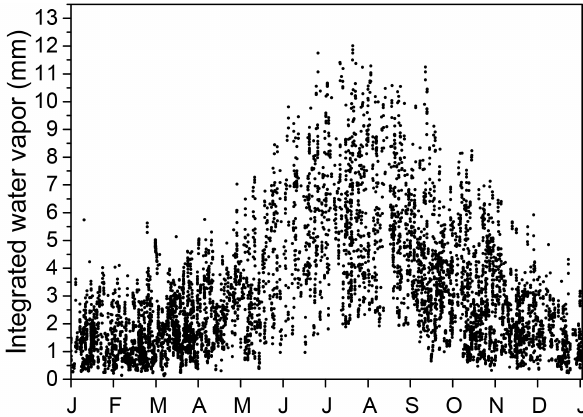
Figure 3. Climatology of integrated water vapor above the Zugspitze. Data are from multi-annual (1996–2013) Zugspitze so- lar FTIR measurements (clear sky, 15–20min integration; see Suss- mann et al., 2009, for details). See Table 1 for related